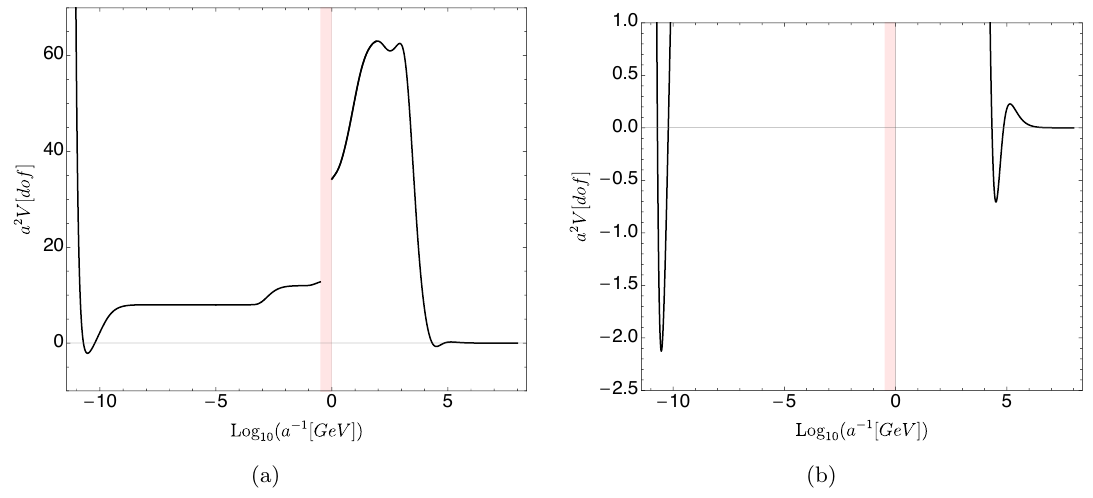
Figure 9 . E(cid:11)ective potential of the Standard Model compacti(cid:12)ed in T 2 =Z 4 and embedded into U(1) s . The masses of all superpartners of the SM particles are set to 1 TeV except for the gluinos (16 d.o.f.), m g = 18 TeV and 1 squark (12 d.o.f.), m squark = 23 TeV. (b) displays a zoom in of